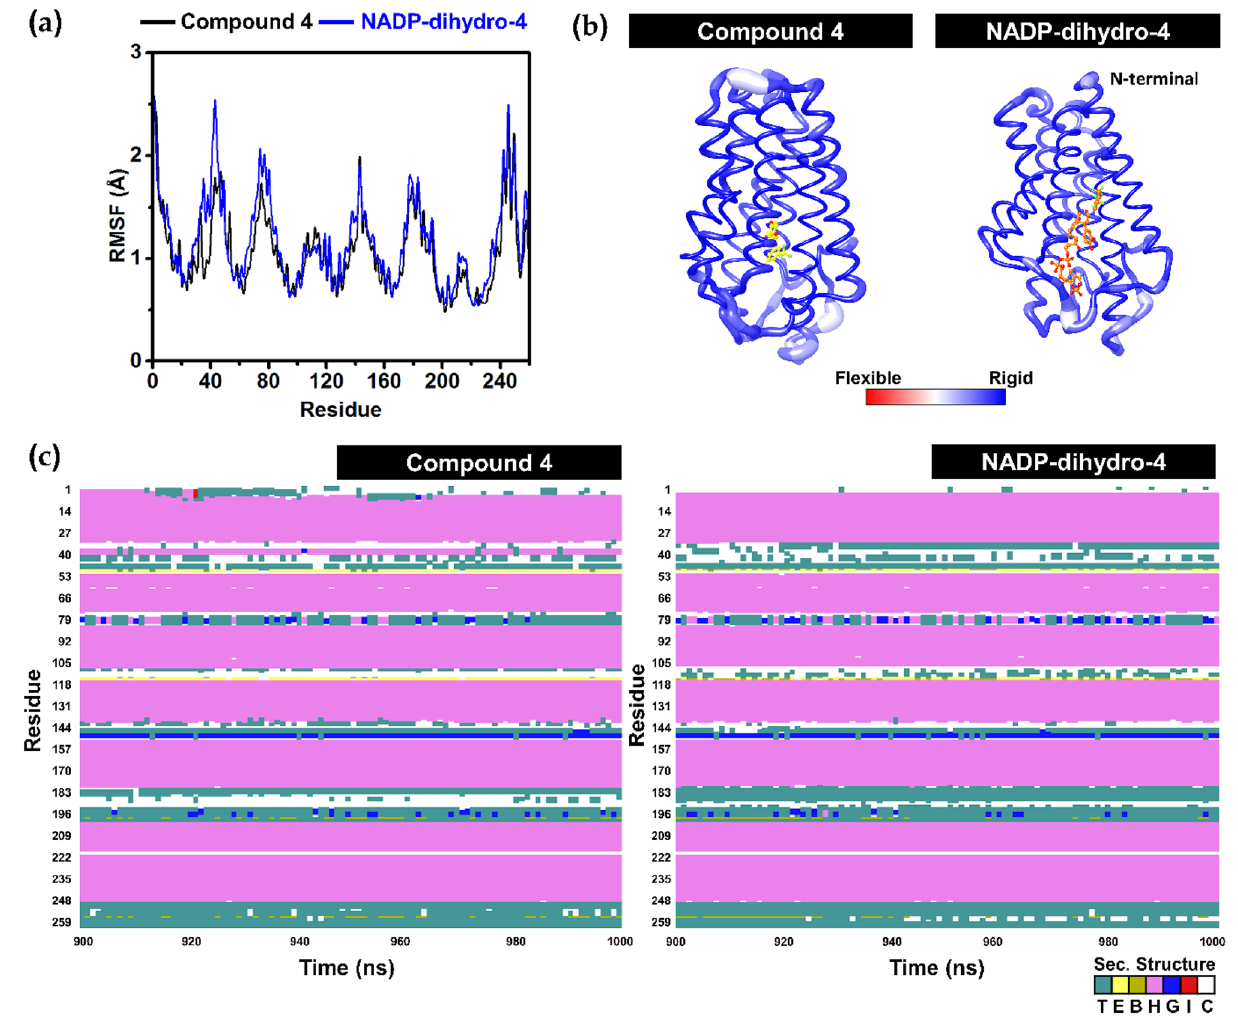
Figure 11. Structural investigations of the SRD5A1 in complex with compound 4 and NADP-dihydro- 4 along with the MD simulations (Run 1). ( a ) RMSF and ( b ) B-factor of SRD5A1 protein. ( c ) Secondary structure timeline analysis as computed by VMD, where the turn (T) and extended conformation (E) are represented in teal and yellow, respectively; isolated bridges are in dark yellow; α-helix is in pink (H), blue (3–10 helix) and red (π-helix); and random coils are in